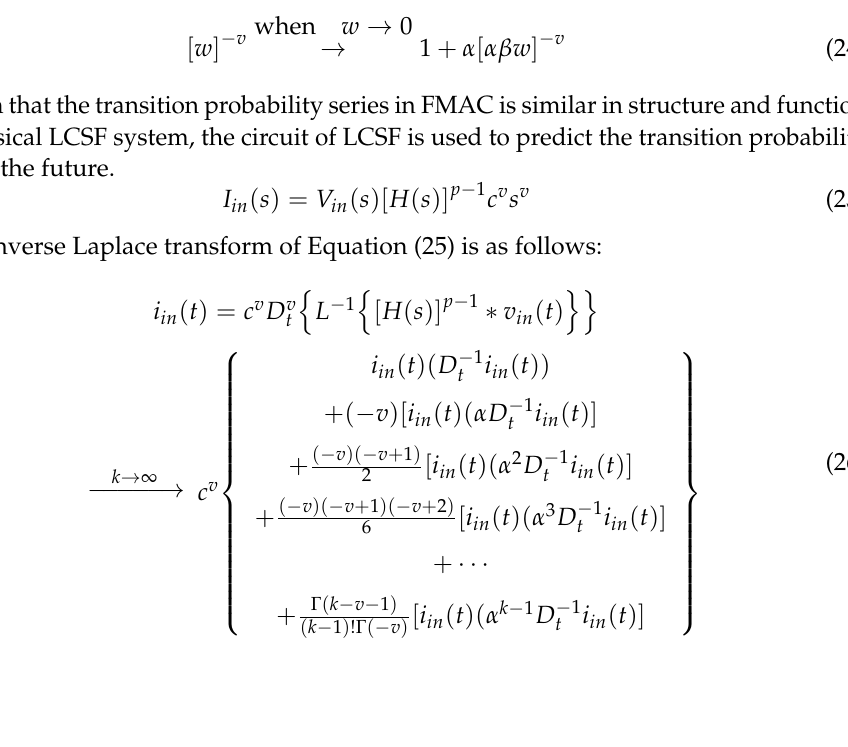
approximated as Equation (24),